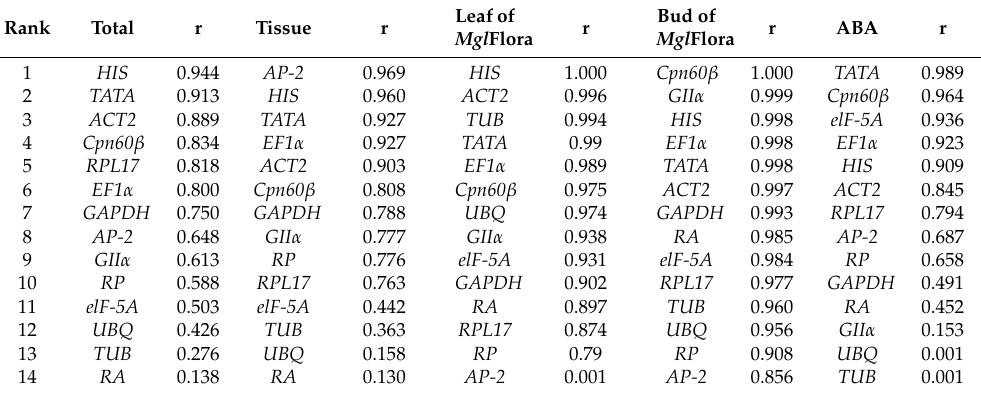
Abbreviations: ABA: Abscisic Acid treatment; r: correlation coefficient.